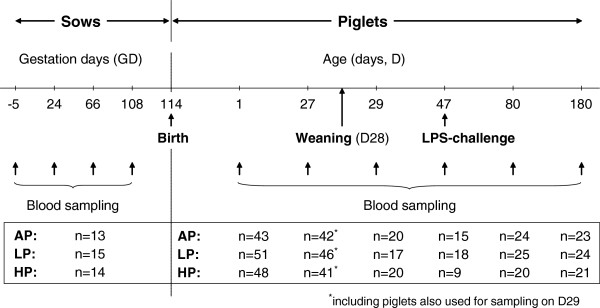
Timeline: summary of blood sampling and distribution of animals in different diet groups.  Sows were fed adequate (AP, 12.1%), low (LP, 6.5%) and high (HP, 30%) dietary protein levels throughout gestation.